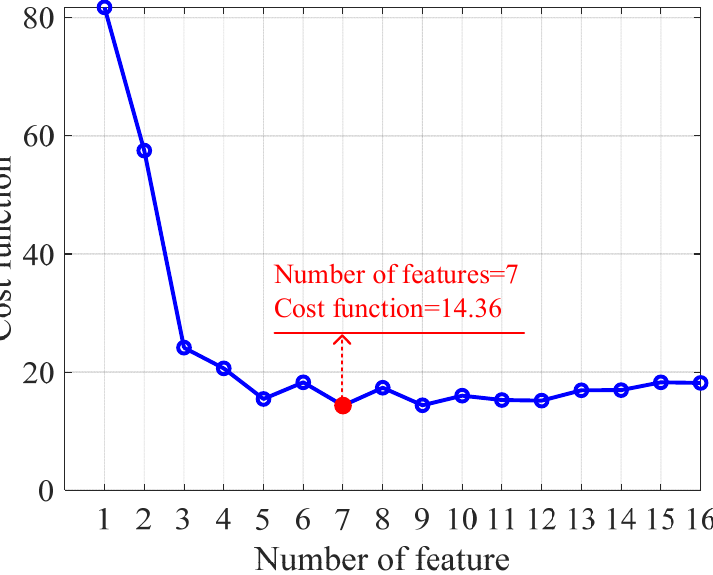
Figure 7. The value of the cost function is calculated by the PSO algorithm in terms of the number of features.